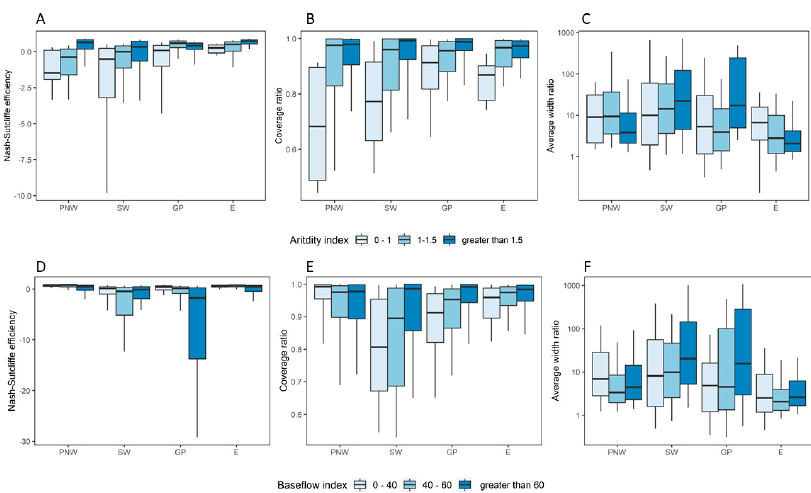
Figure 8. Nash–Sutcliffe efficiency of daily streamflow estimates and coverage ratio and average width index (AWI) of 95 percent uncertainty intervals, grouped by aridity index ( A – C ) and baseflow index ( D – E ) at 1331 validation sites in four regions of the study area: Pacific Northwest and mountains (PNW), Southwest (SW), Great Plains (GP), and Eastern U.S. (E). Boxplot whiskers extend to the 10th and 90th percentiles of the distribution, box ends represent the 25th and 75th percentiles, and the horizontal line represents the median.